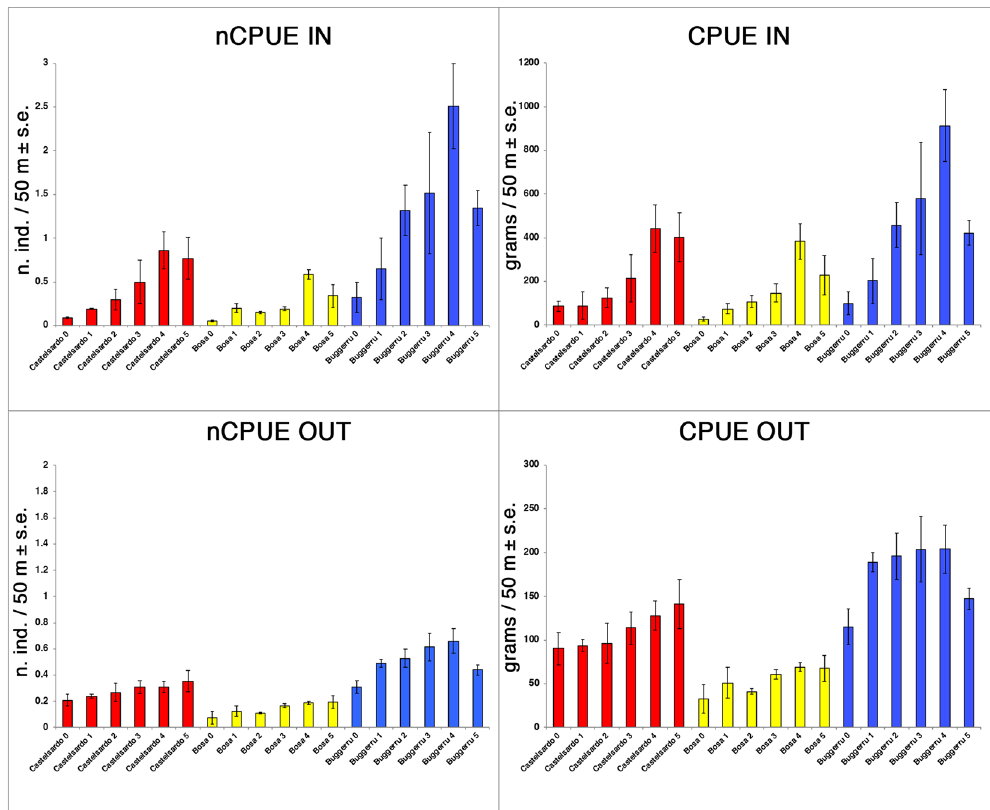
Figure 2. Plot showing annual CPUE (gr/50 m ± s.e.) and nCPUE trends (n. ind/50 m ± s.e.) inside (upper graph) and outside (lower graph) FPAs borders before the beginning (time zero) and during restocking (time 1, 2, 3, 4,